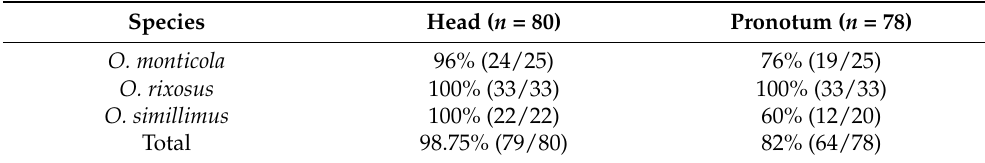
Table 3. Percentage of correctly classified specimens based on cross-checked classification for head and